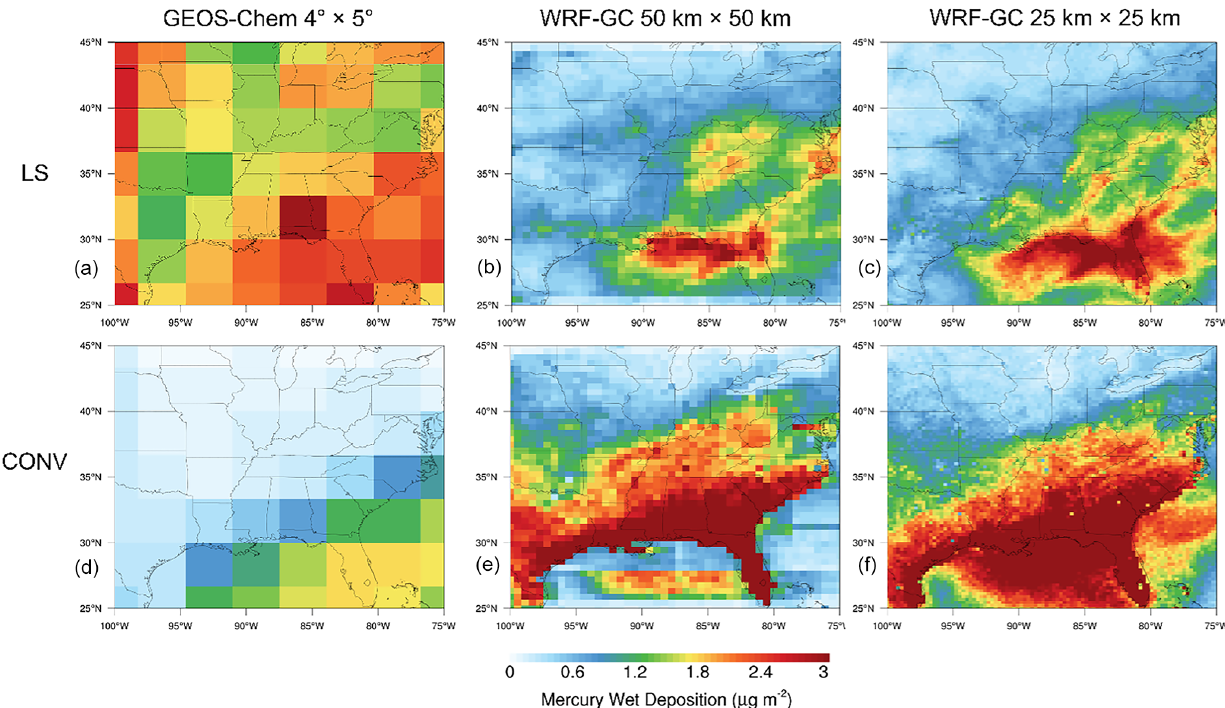
Figure 9. Comparison of different types of wet deposition of GEOS-Chem and WRF-GC. Panels (a, b, c) show LS, and panels (d, e, f) show CONV. Panels (a, d) show GEOS-Chem 4 ◦ × 5 ◦ simulation results. Panels (b, e) – (c, f) correspond to different WRF-GC resolutions: 50km × 50km and 25km ×